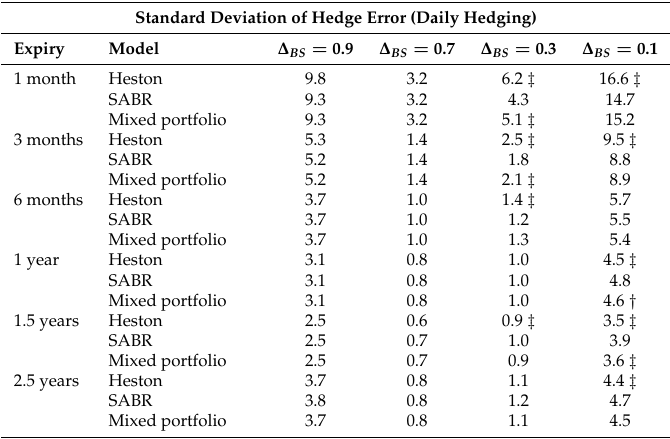
Table 4. Hedge errors (in the scaled standard deviation sense of Equation (24)) from daily hedging for each expiry, model and moneyness (measured by the Black–Scholes call Delta ∆ BS ). The symbols ‡ and † indicate significance at the 1% and 5% levels for testing if the standard deviation of Heston and the mixed portfolio, respectively, are different from SABR. The symbols therefore only appear for rows related to Heston and the mixed portfolio. Significance is tested using the Brown–Forsythe test of Brown and Forsythe (1974) with the central locations estimated by the